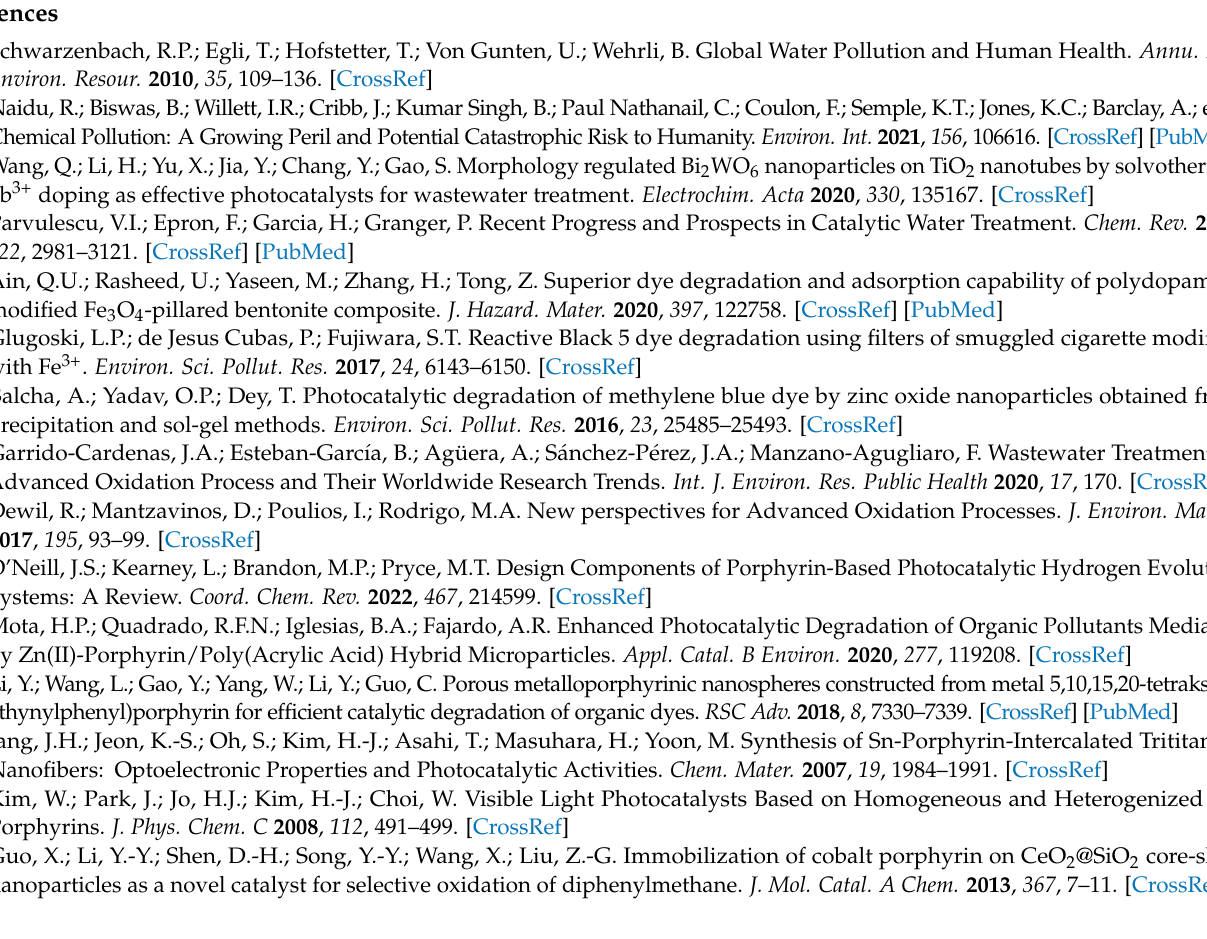
Figure S16: Comparison of FE − SEM images of SnP@MCM − 41 before and after the degradation of EG dye; Figure S17: Effect of the temperature on the degradation of the EG dye by SnP@MCM − 41 ; Figure S18: Effect of the pH of the solution of the EG dye for photodegradation by SnP@MCM − 41 ; Figure S19: Effect of the concentration of the EG dye for photodegradation by SnP@MCM − 41 (20 mg) within 90 min of visible light irradiation; Figure S20: Effect of the amount of SnP adsorbed onto SnP@MCM − 41 composite for photocatalytic degradation of EG dye, where X = mmol of SnP per gram of MCM − 41; Figure S21: ESI-MS spectrum (negative ion mode) of the reaction mixture of EG in the presence of SnP@MCM − 41 after 45 min of visible light